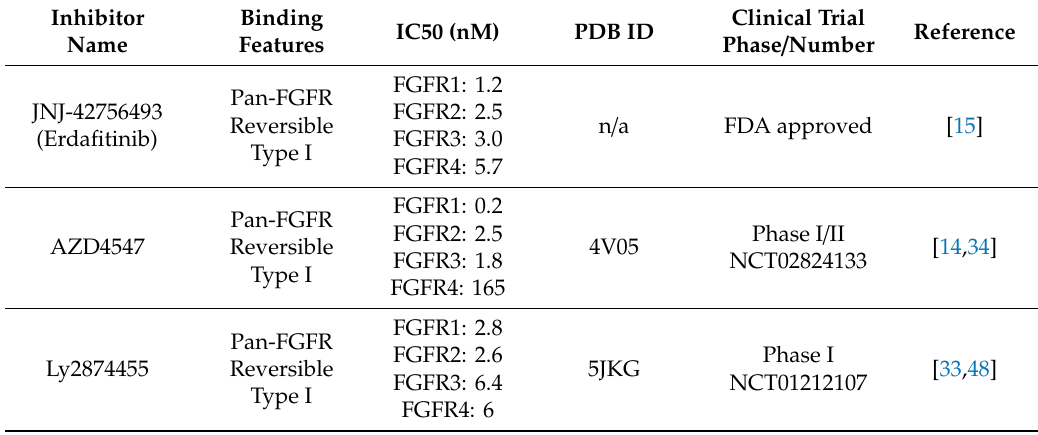
Table 1. FGFR inhibitors that are in clinical trials or approved by the